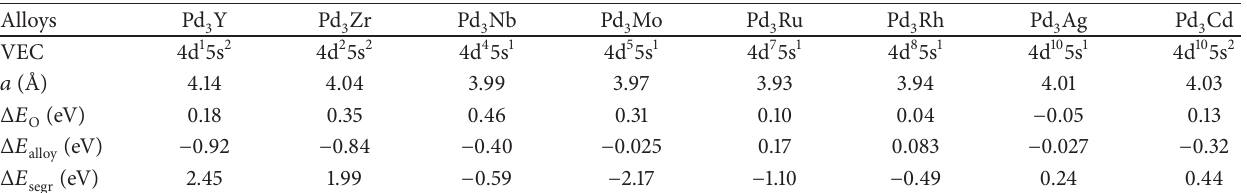
(eV) for various segr M(111) and Pt(111) surface, 3